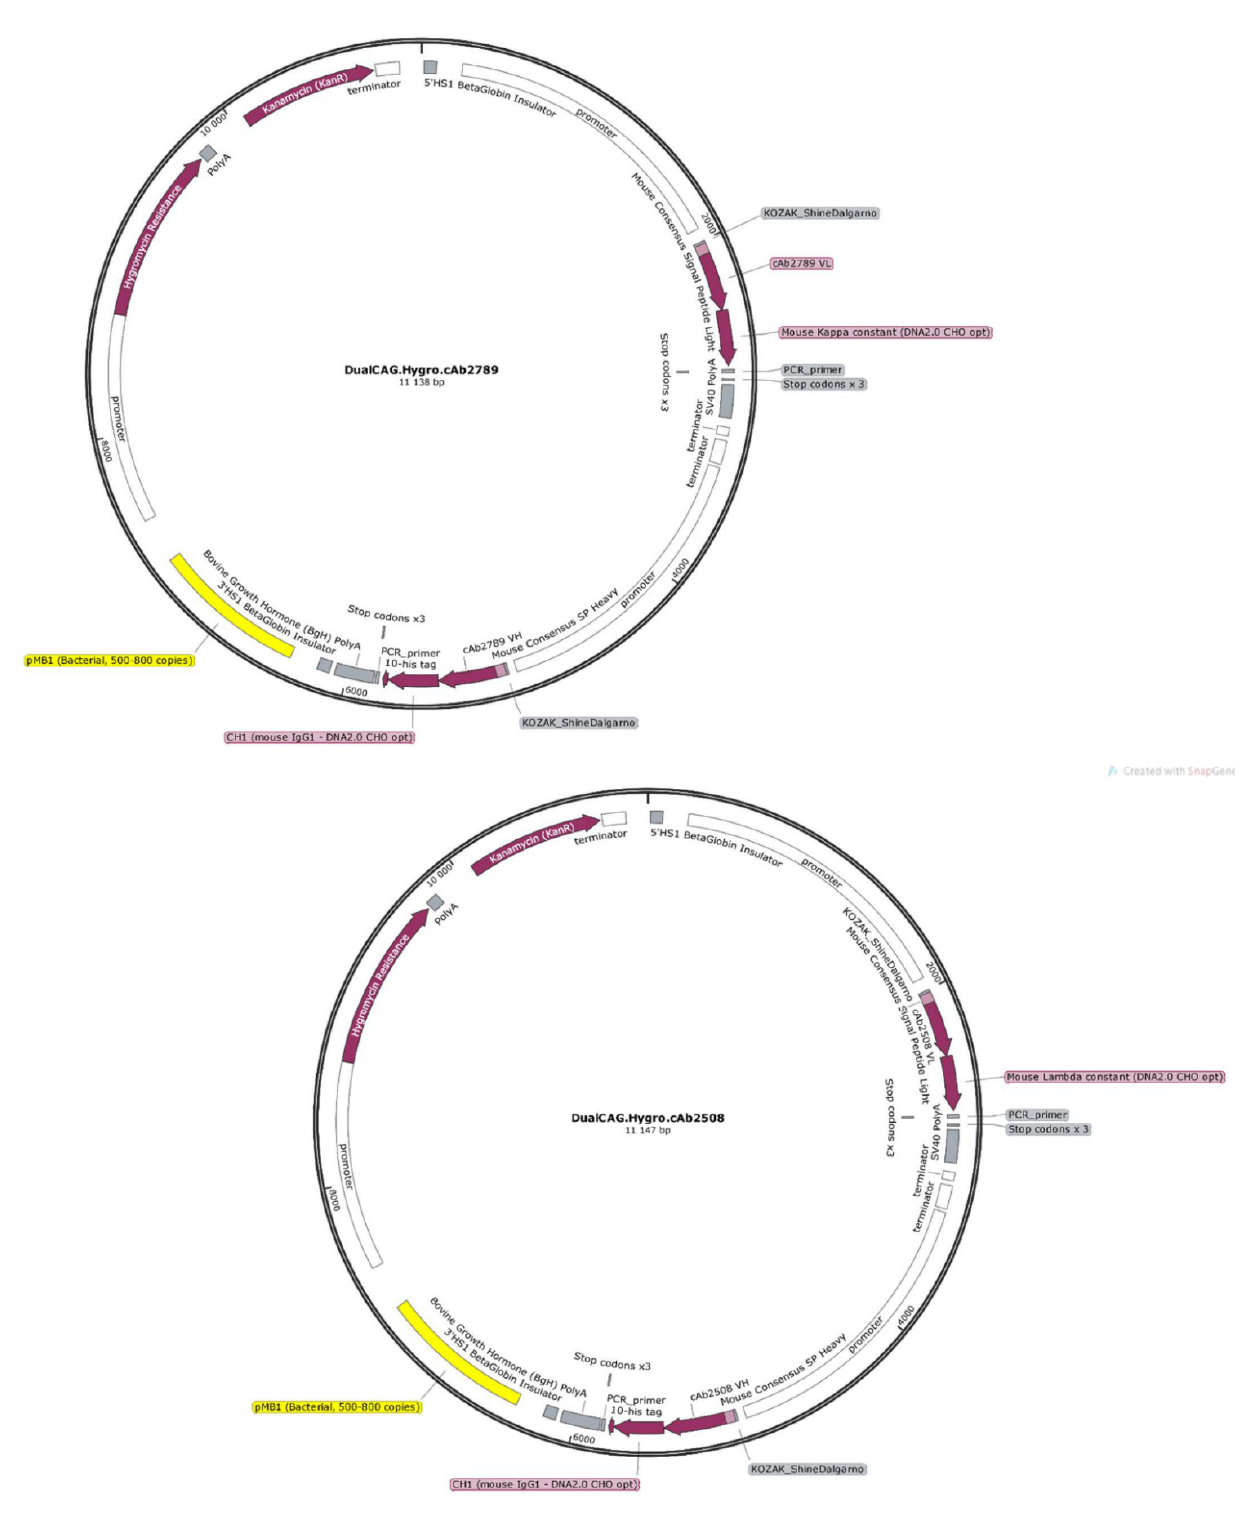
Figure 3. Fabs-encoding vectors maps. To be able to express and secrete anti-TDP-43 and anti- β -amyloid Fabs by endothelial progenitor cells, new expression vectors were created. pl.DualCAG.Hygro.cAb2789 and pl.DualCAG.Hygro.cAb2508 encode the expression of anti- β -amyloid Fab and anti-TDP-43 Fab, respectively. They encode both chains of the Fabs (CH1-VH and CL-VL) with optimized peptide signals driven by dual CAG promoters. In addition, a 10-His tag, a ubiquitin promoter with a downstream hygromycin resistance and a polyadenylation sequence, were added.